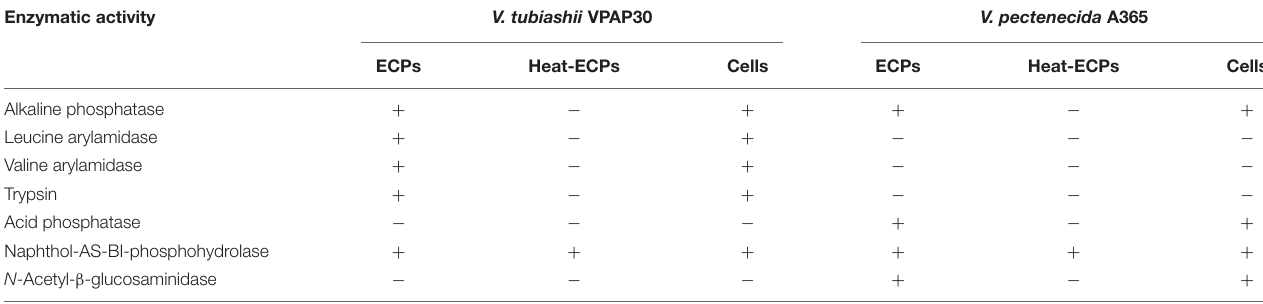
TABLE 3 | Comparative enzymatic activities displayed by whole cells and ECPs of V. tubiashii VPAP30 and V . pectenicida A365. Enzymatic activity